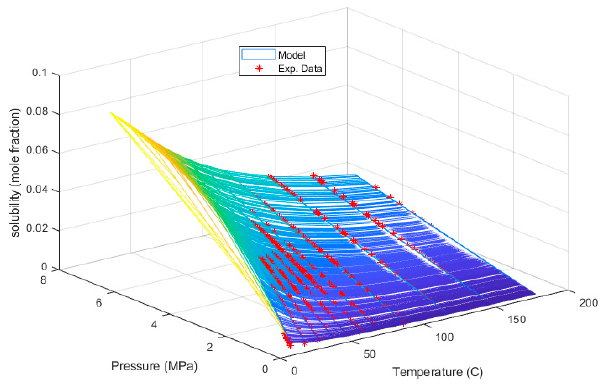
Figure 7. Validation of pure H 2 S solubility with experimental data (Diamond et al.